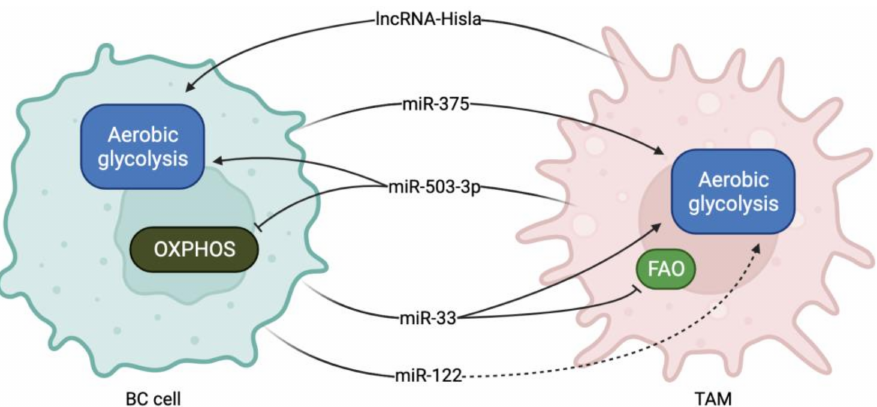
Figure 2. miRNAs and lncRNAs involved in TAM-BC crosstalk during metabolism reprogramming. LncRNA Hisla and miR-503-3p are secreted from TAMs and collected by BC cells, where they promote aerobic glycolysis and suppress OXPHOS. Instead, miR-375, miR-33 and miR-122 are secreted by BC cells and promote glycolysis upregulation and FAO inhibition in